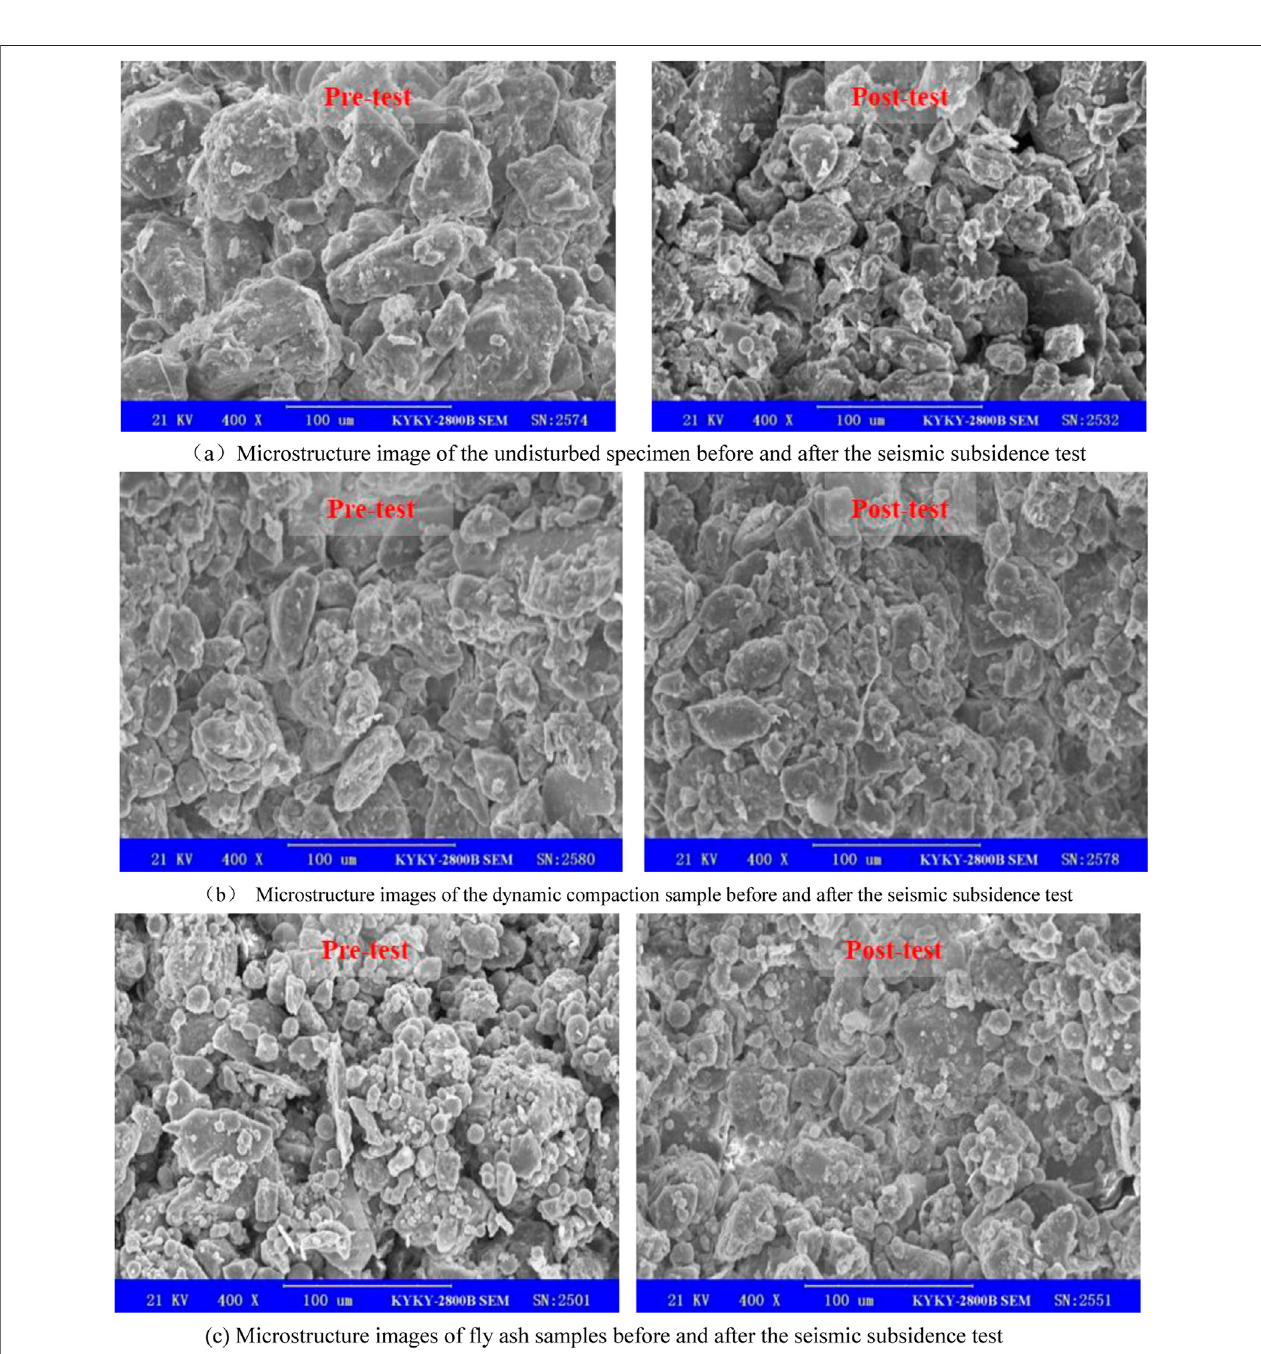
Figure 2B . Before the test, the loess shows obvious fl occulent structure. The large aggregates collapsed due to compaction and further broke into small aggregates; the particles were arranged more densely, and they are in the area of contact. After the test, the vibrating effect of the strong earthquake makes the granular mosaic structure of the dynamic compaction sample after the